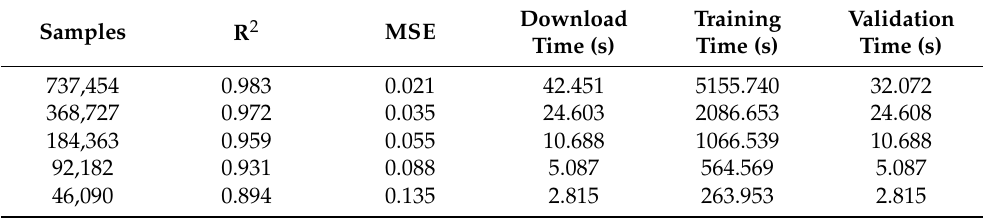
Table 7. Training: Reduced